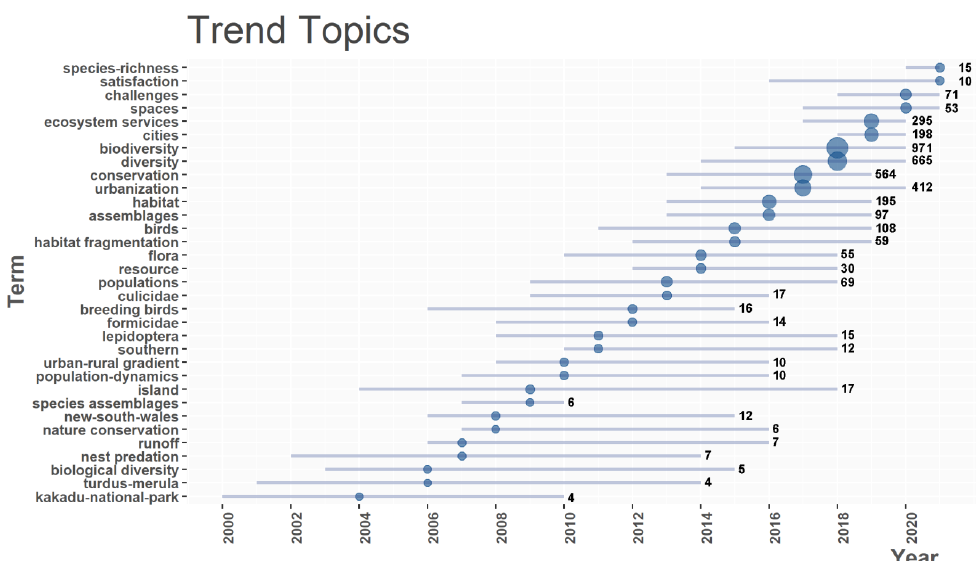
Figure 6. Annual change of keyword nodes number and research development progress.